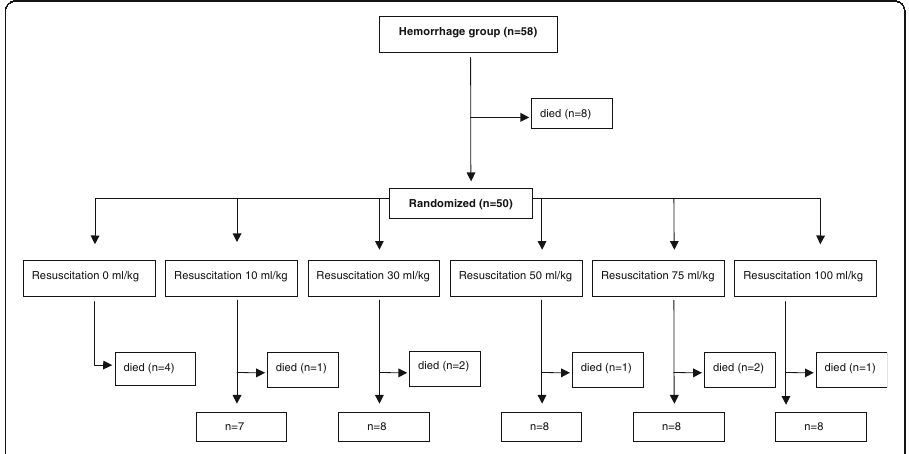
Fig. 3 Flow chart of animals in the hemorrhage